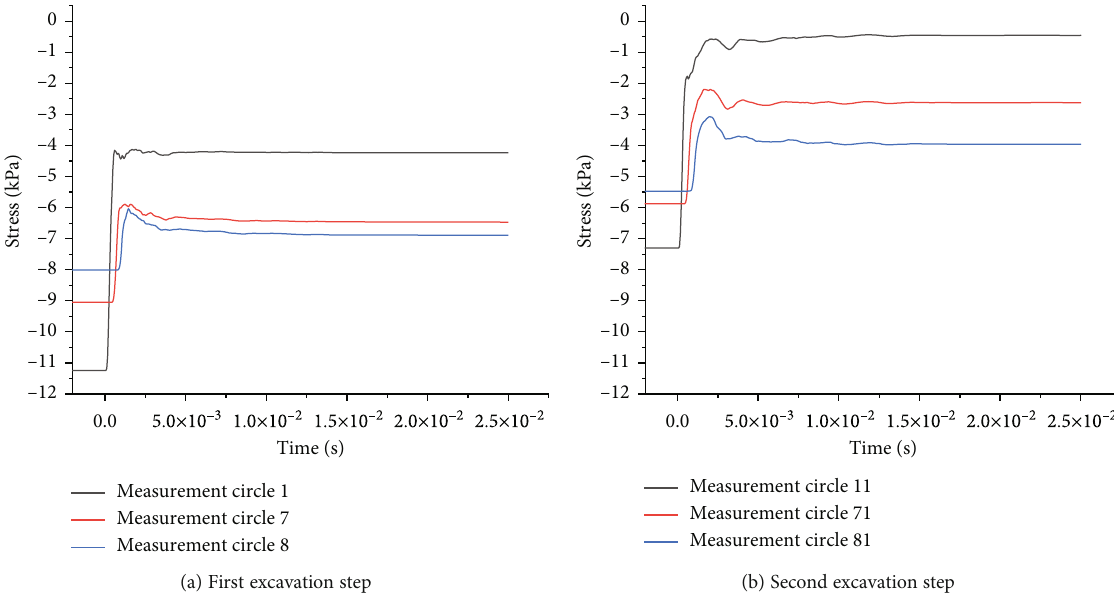
Figure 12: Stress evolution in the overlying strata at vertical intervals of 0.09m on the upper right-hand corner of the roof after the fi rst excavation step (measurement circles 1, 7, and 8) and after the second excavation step (measurement circles 11, 71, and